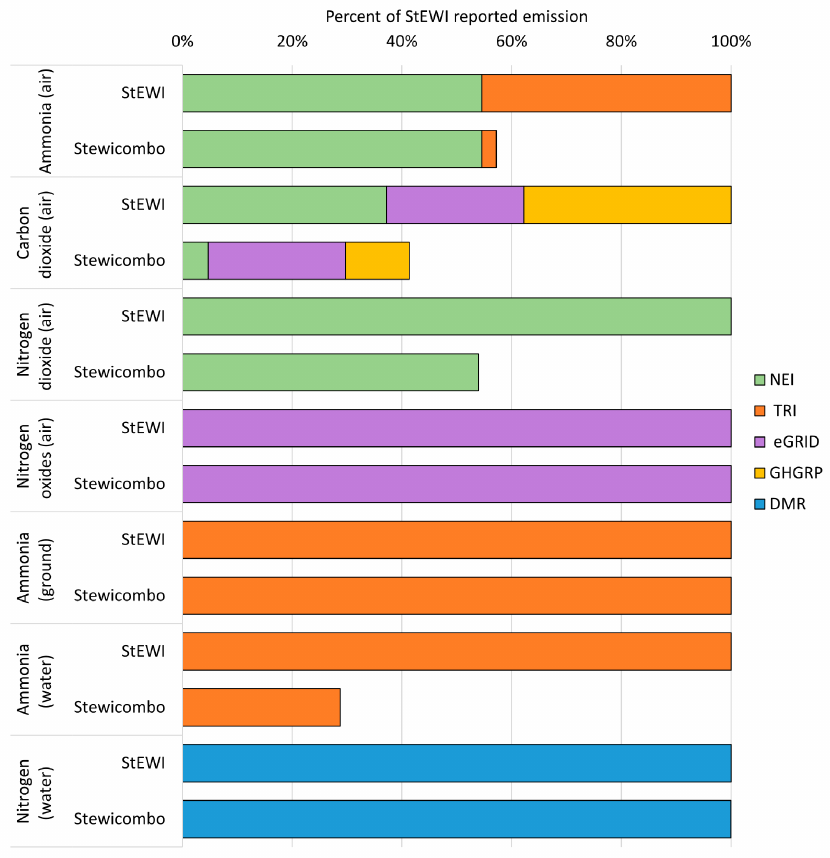
Figure 4. Reducing overlap with stewicombo (reporting year 2018).